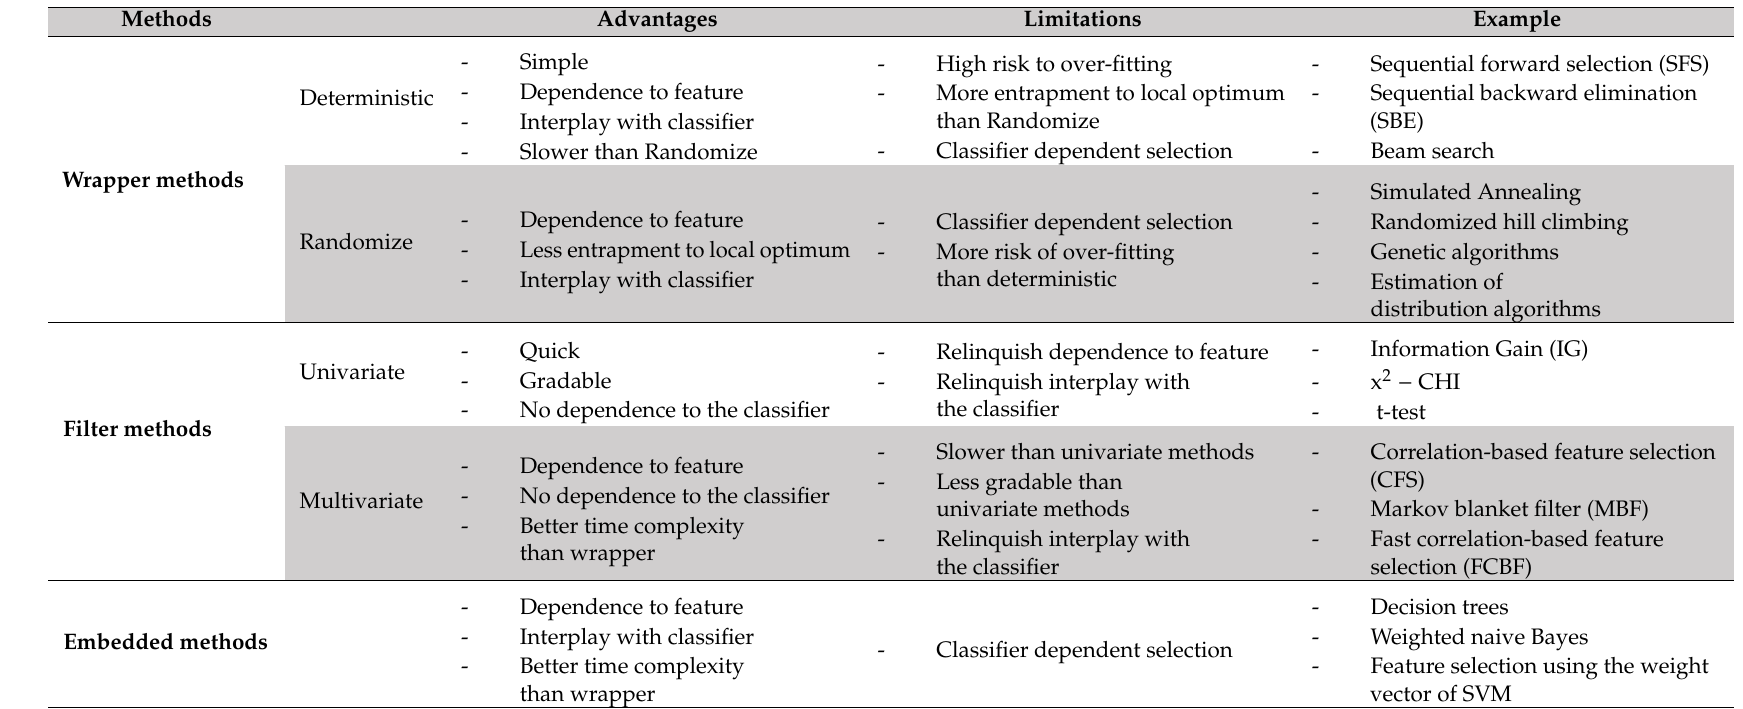
Table 5. A category of di ff erent feature selection methods, their advantages and